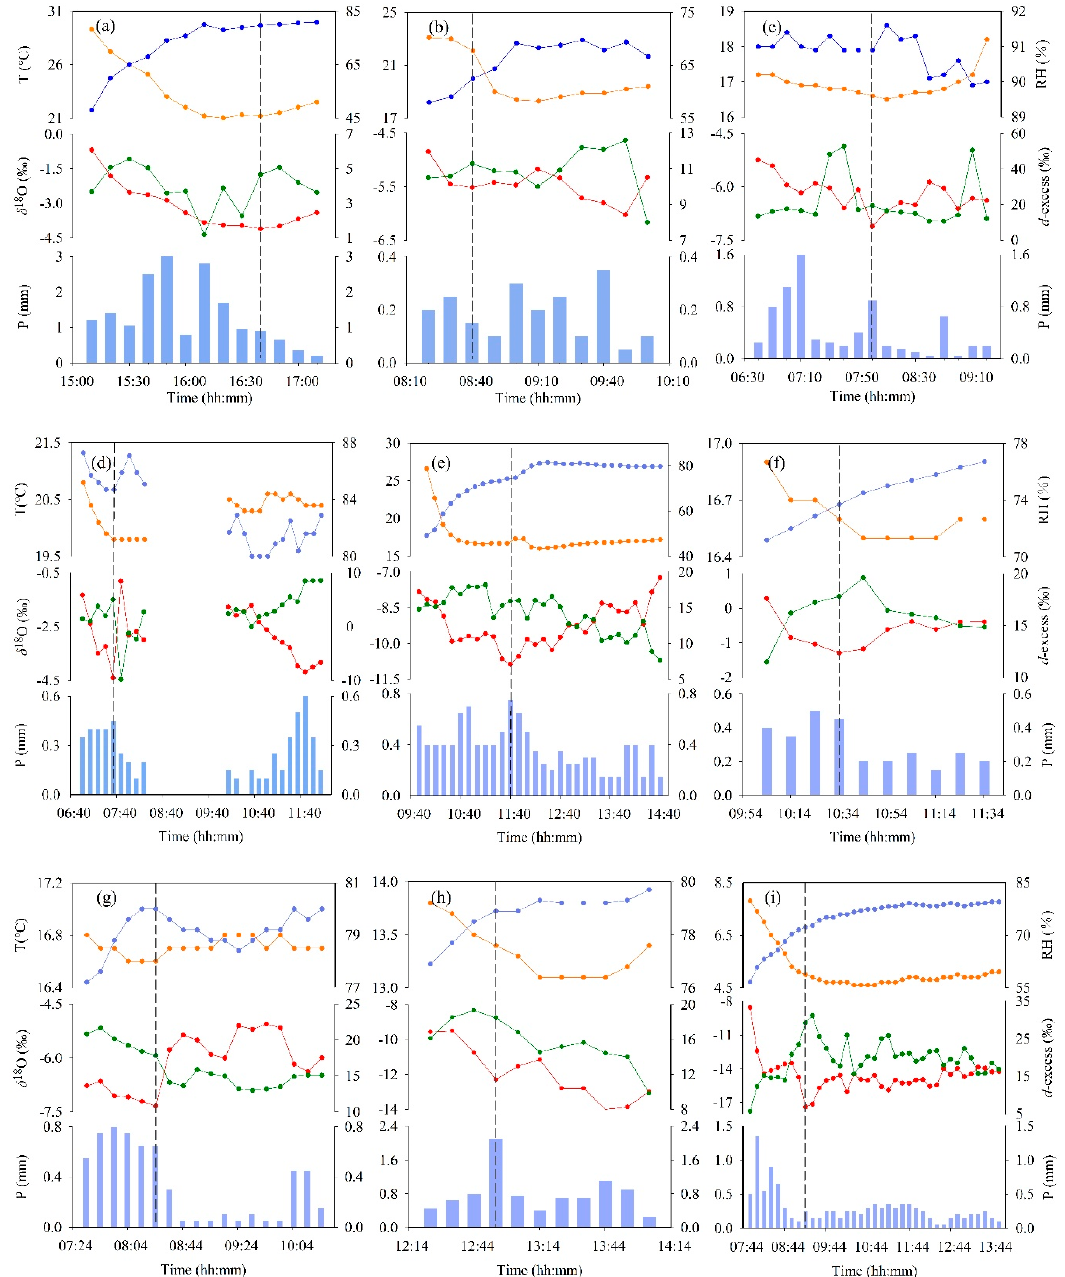
Figure 3. Characteristics of the δ 18 O values (red) of the sequentially sampled precipitation with a time series of the d -excess (green), air temperature (T, orange), relative humidity (RH, blue), and precipitation amount (P) for nine events at the sampling site: ( a ) E1; ( b ) E2; ( c ) E3; ( d ) E4; ( e ) E5; ( f ) E6; ( g ) E7; ( h ) E8; and ( i ) E9. The vertical gray dotted line divides two periods of each continuous precipitation event based on δ 18 O.